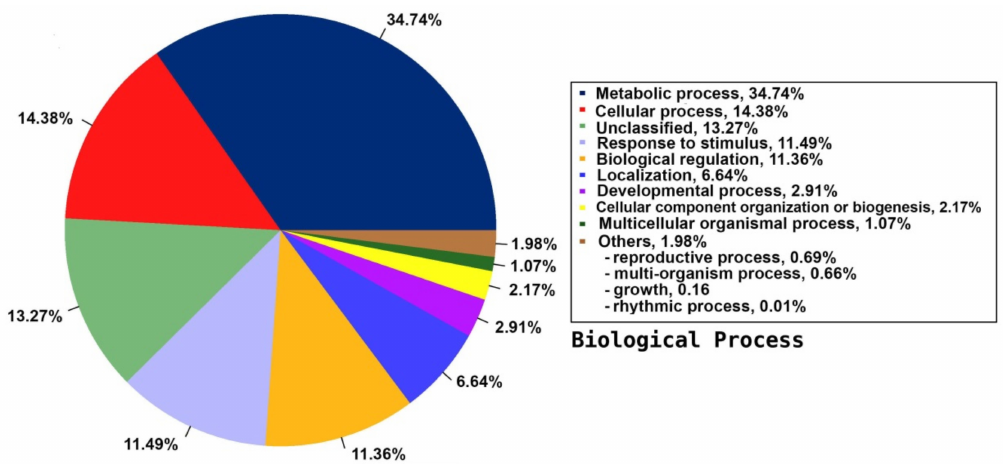
Figure 3. Distribution of the annotated BP to the GO database using the detected unigenes of the jojoba transcriptome of developing seeds.